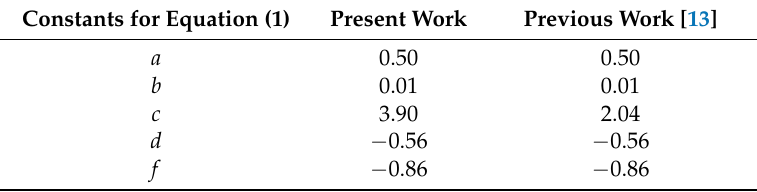
Table 3. Constants of Equation (2) for film thickness